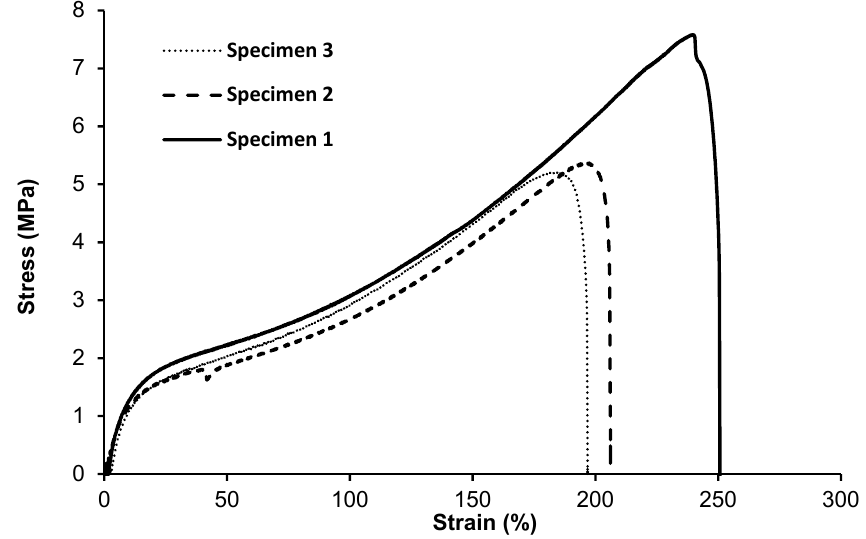
Figure 7. X-ray diffraction pattern of MCL-PHA terpolyester sample.